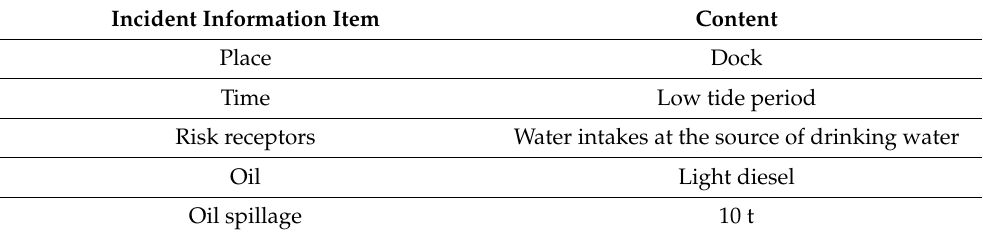
Table 10. Accident information.